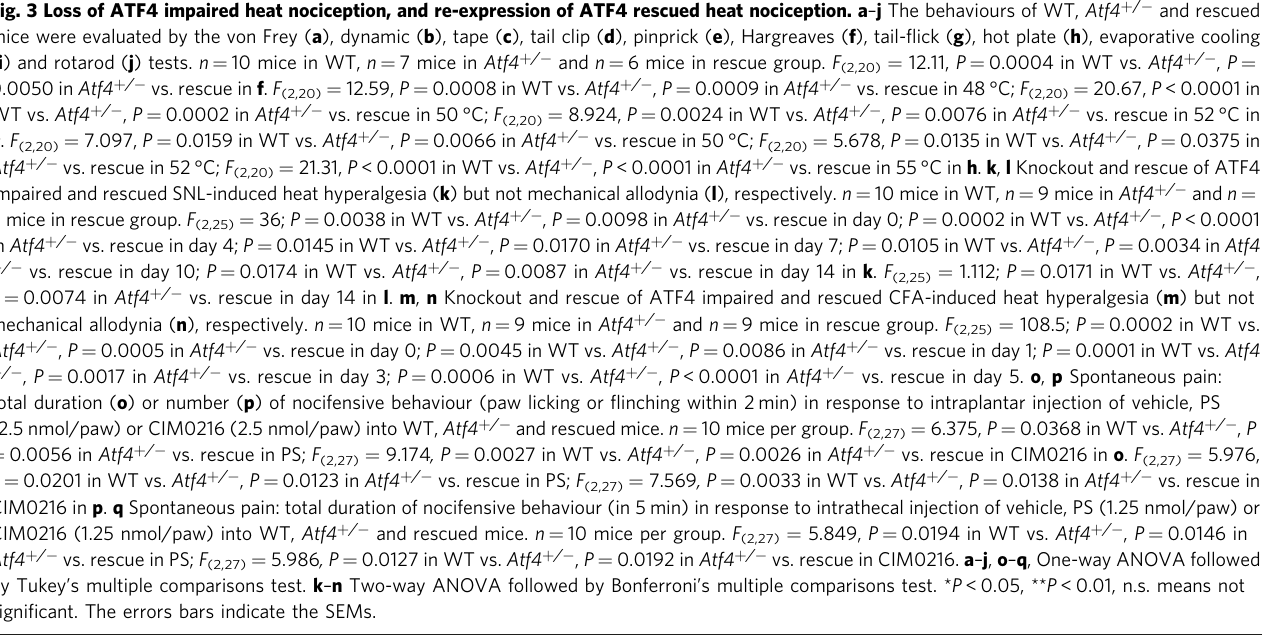
Fig. 3 Loss of ATF4 impaired heat nociception, and re-expression of ATF4 rescued heat nociception. a – j The behaviours of WT, Atf4 + / − and rescued mice were evaluated by the von Frey ( a ), dynamic ( b ), tape ( c ), tail clip ( d ), pinprick ( e ), Hargreaves ( f ), tail- fl ick ( g ), hot plate ( h ), evaporative cooling ( i ) and rotarod ( j ) tests. n = 10 mice in WT, n = 7 mice in Atf4 + / − and n = 6 mice in rescue group. F (2,20) = 12.11, P = 0.0004 in WT vs. Atf4 + / − , P = 0.0050 in Atf4 + / − vs. rescue in f . F (2,20) = 12.59, P = 0.0008 in WT vs. Atf4 + / − , P = 0.0009 in Atf4 + / − vs. rescue in 48 °C; F (2,20) = 20.67, P < 0.0001 in WT vs. Atf4 + / − , P = 0.0002 in Atf4 + / − vs. rescue in 50 °C; F (2,20) = 8.924, P = 0.0024 in WT vs. Atf4 + / − , P = 0.0076 in Atf4 + / − vs. rescue in 52 °C